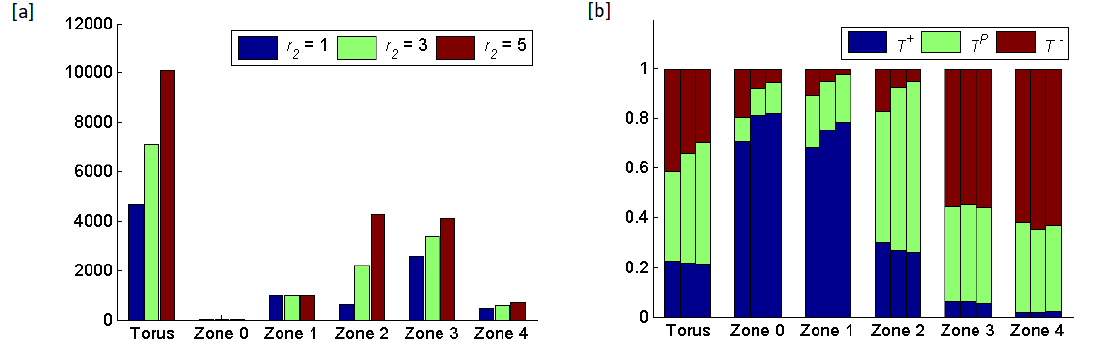
Figure 7. Results of increasing the radius of zone 1, r 1 , from 1 to 5, while keeping the radii of the other zones ( r 2 and r 3 ) at 3. ( a ) The total number of cells in the torus and in each zone. The average rates at which cells land in zone 0 and become circulating tumor cells are 3.20, 2.88, and 2.70 cells per generation, respectively, for r 1 equal 1, 3 and 5. ( b ) The frequencies of the three cell types per zone shown as triplets of stacked bars where the order of bars per triplet shows r 1 = 1, 3, 5.